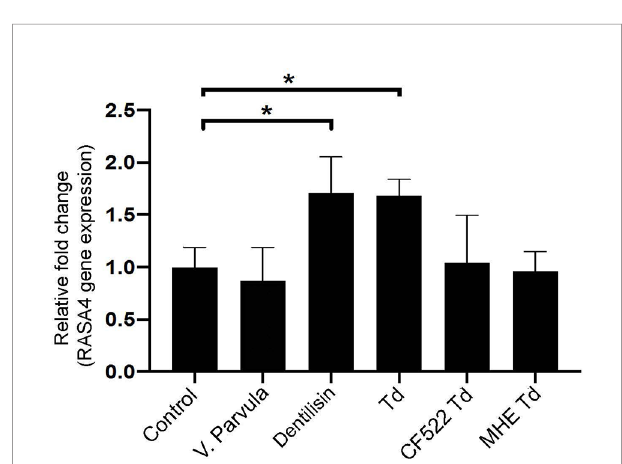
FIGURE 4 | Puri fi ed dentilisin and T. denticola upregulate RASA4 gene expression in PDL cells. Quantitative RT-PCR analysis of RASA4 relative fold change in PDL cells challenged with V. parvula , wild type T. denticola , T. denticola dentilisin mutant CF522, T. denticola MHE or treated with puri fi ed dentilisin for 24 h. Data represent mean ± SD from three independent experiments. Data were compared using One-way ANOVA Tukey ’ s Multiple comparisons test. * =